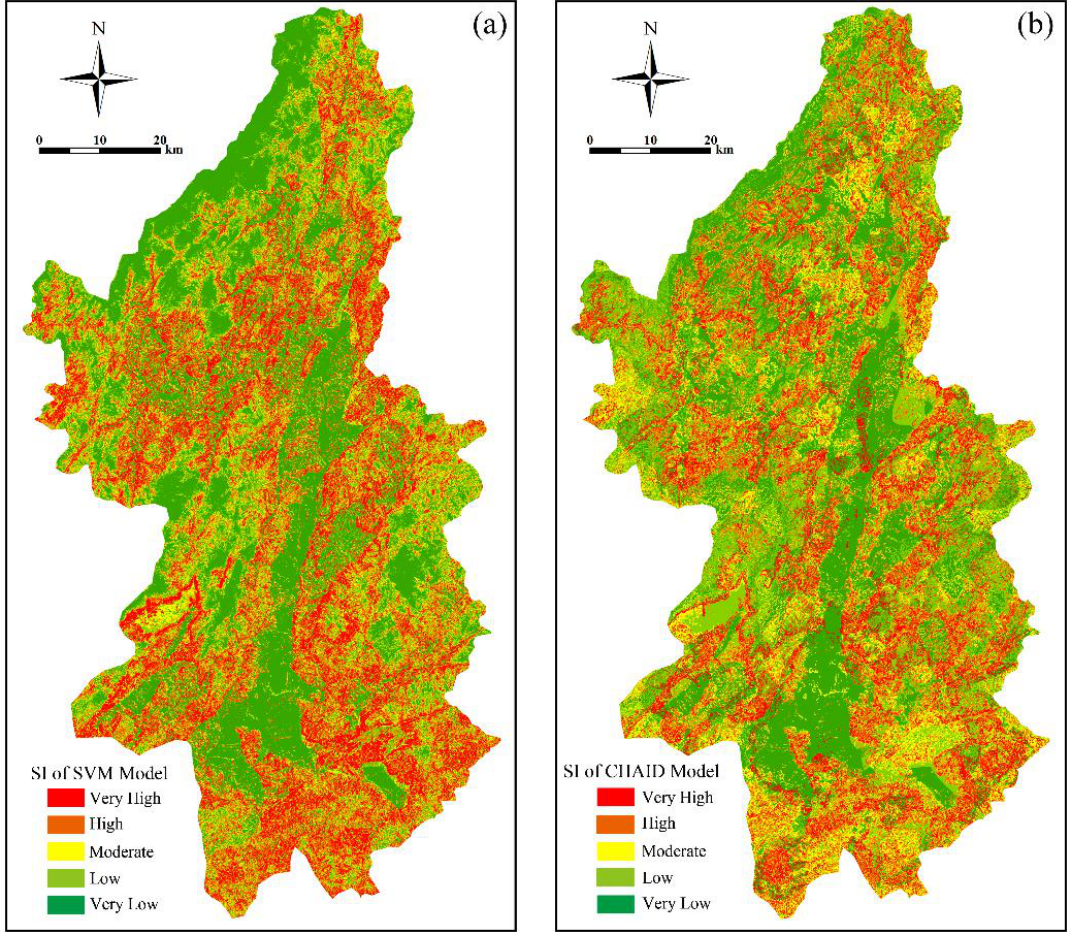
Figure 4. LSMs of the support vector machine (SVM) model ( a ) and CHi-squared Automatic Interaction Detection (CHAID) model ( b ).